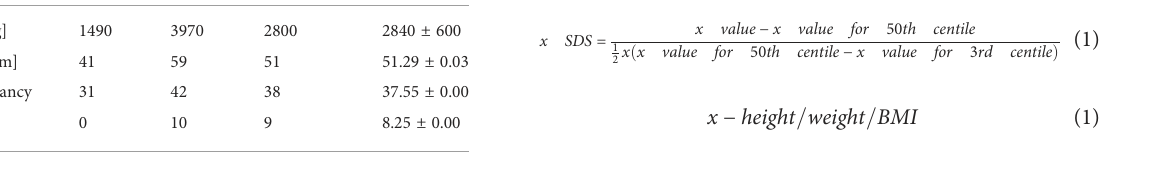
TABLE 2 Characteristics of postpartum parameters in the group of breastfed-children (85 children; 18 babies were born ≤ 36hbd). Min.